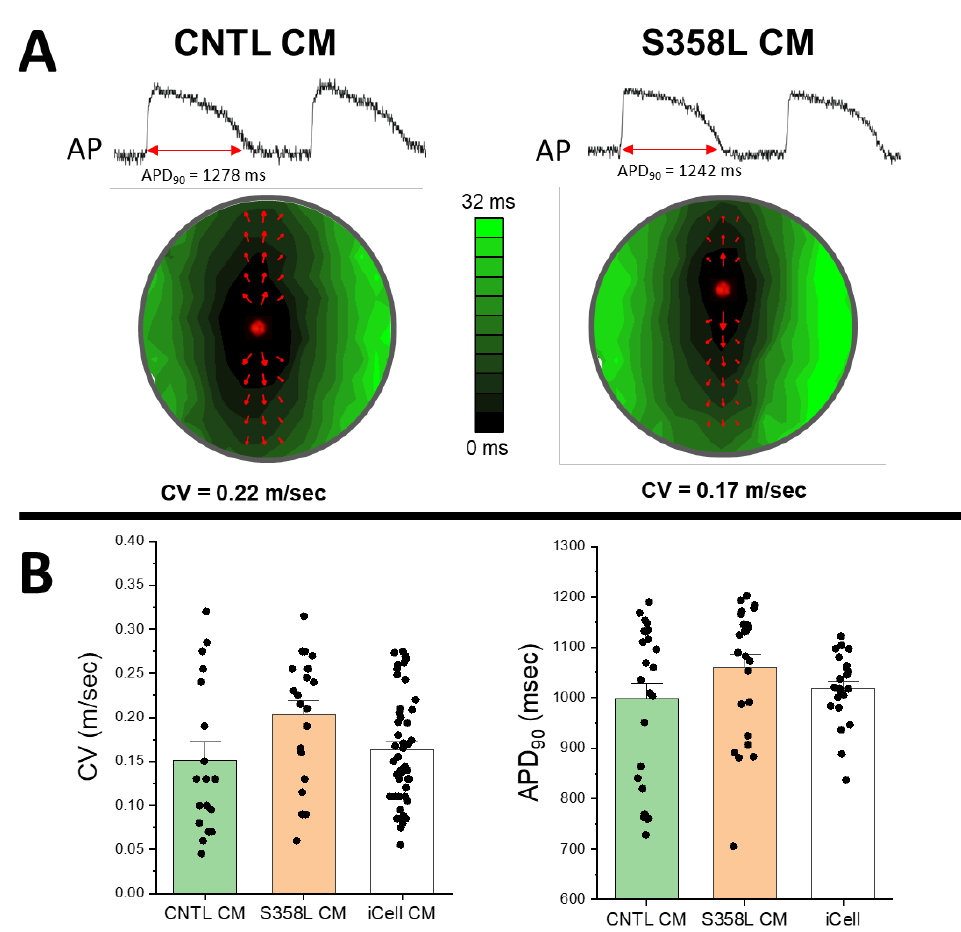
Figure 4. Representative examples of action potentials and activation maps ( A ) recorded during IR pacing at 2000 ms cycle length from wells with cardiac myocytes (CM) alone that were derived from control (left, CNTL) and S358L ( right ) iPSCs. Action potentials and activation maps show a similar APD 90 , activation pattern, and conduction velocity (red arrows) for CNTL CM and S358L CM. Summary data ( B ) show CV ( left ) and APD 90 (right) measured for each well over multiple differentiations (for iPSC derived CM) and vials (iCells). No significant differences were observed for CV and APD 90 across all groups. For CV: CNTL CM, n = 18; S358L CM, n = 21, iCell CM n = 47. For APD 90 : CNTL CM n = 25; S358L CM, n = 25; iCell CM, n = 22.